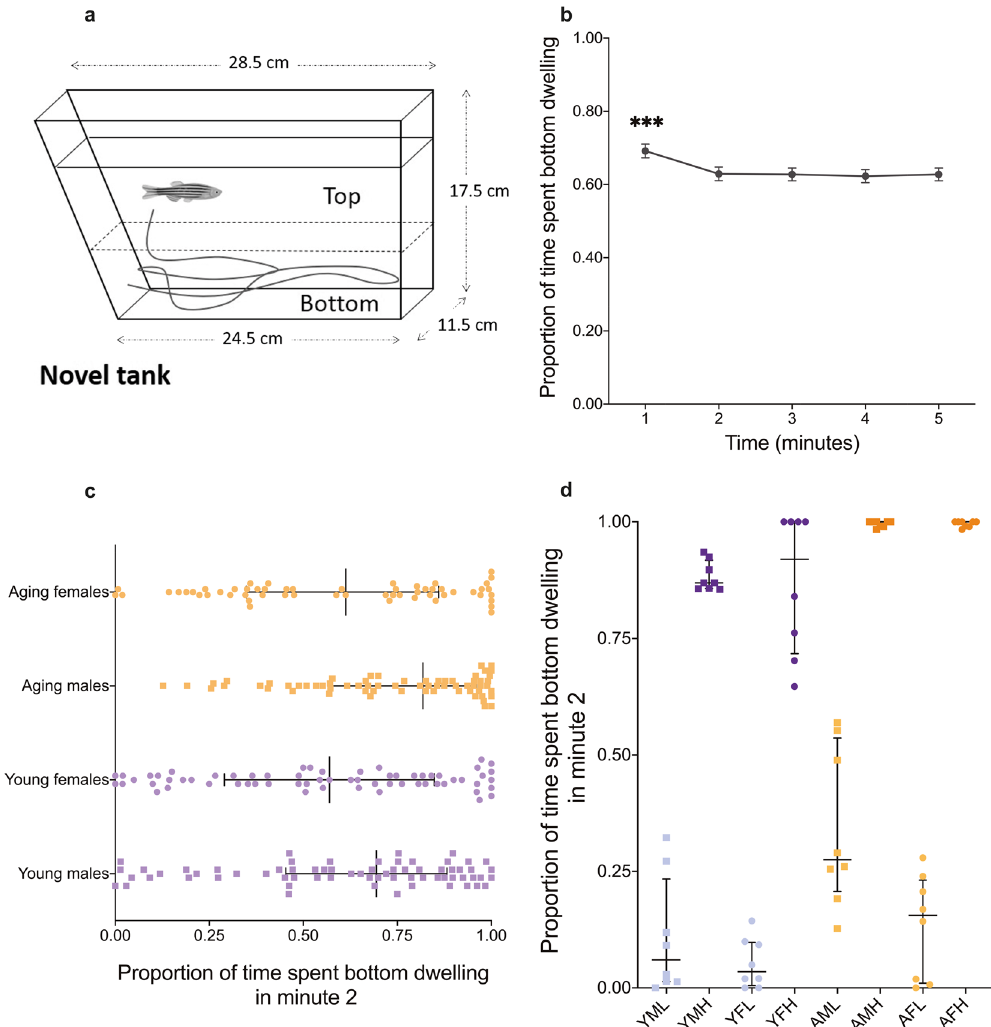
Figure 1. Zebrafish selected for molecular analysis based on behaviourally determined stress reactivity. ( a ) Diagram of the novel tank assay: each fish is individually transferred from its home tank to a novel test tank. The time (seconds) spent in the bottom in each minute was used for analysis. ( b ) Entire population results for bottom dwelling by minute over the course of the novel tank test. ( c ) Population distribution of young (6–9 month) and aging (18 month) males and females based on their bottom dwelling in minute two ( N = 256). ( d ) Bottom dwelling differences in minute two for the fish selected for molecular analysis ( N = 64). Note that ( d ) corresponds to either extreme of the population distribution in ( c ). Error bars in ( b ) represent ± standard error mean (SEM). For ( c ) and ( d ) middle lines indicate median values and error bars represent interquartile range. YFL young female low stress reactivity, YFH young female high stress reactivity, YML young male low stress reactivity, YMH young male high stress reactivity, AFL aging female low stress reactivity, AFH aging female high stress reactivity, AML aging male low stress reactivity, AMH aging male high stress reactivity. *** p -value <